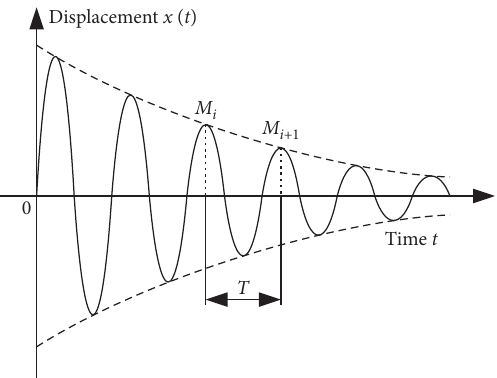
Figure 4: Damped free vibration response of the rotor bearing